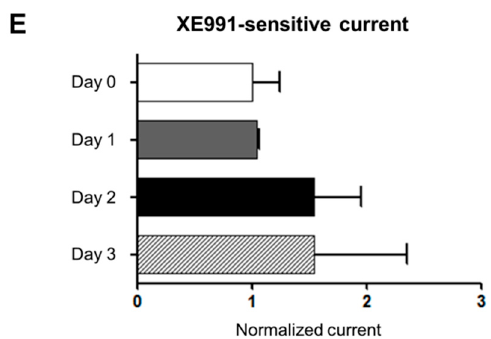
Figure 4. Functional characteristics of K V 7.3 channel in MG-63 cells during osteoblast differentiation. ( A ) Representative current responses to depolarizing steps observed at day 0 of undifferentiated MG-63 cells. XE991-sensitive currents were obtained by the subtraction of the currents in controls from in the presence of XE991 (50 μ M); ( B ) Current-voltage relationships in controls and in the presence of XE991 at day 0 ( n = 3); ( C ) Representative current responses to depolarizing steps observed at day 2 of osteoblastic differentiation; ( D ) Current-voltage relationships in controls and in the presence of XE991 at day 2 ( n = 4); ( E ) XE991-sensitive currents at days 0–4 were normalized by mean current value at day 0. At day 1 of osteoblast differentiation, normalized XE991-sensitive currents had no significant change. At days 2 and 3, the K V 7.3 currents were increased, but not statistically significant. Data are presented as mean ± SEM. * p < 0.05.